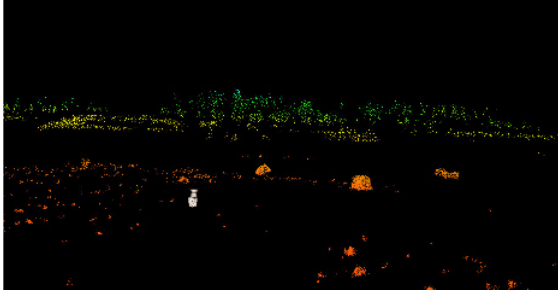
Figure 10: Ground segmented out, leaving only above ground